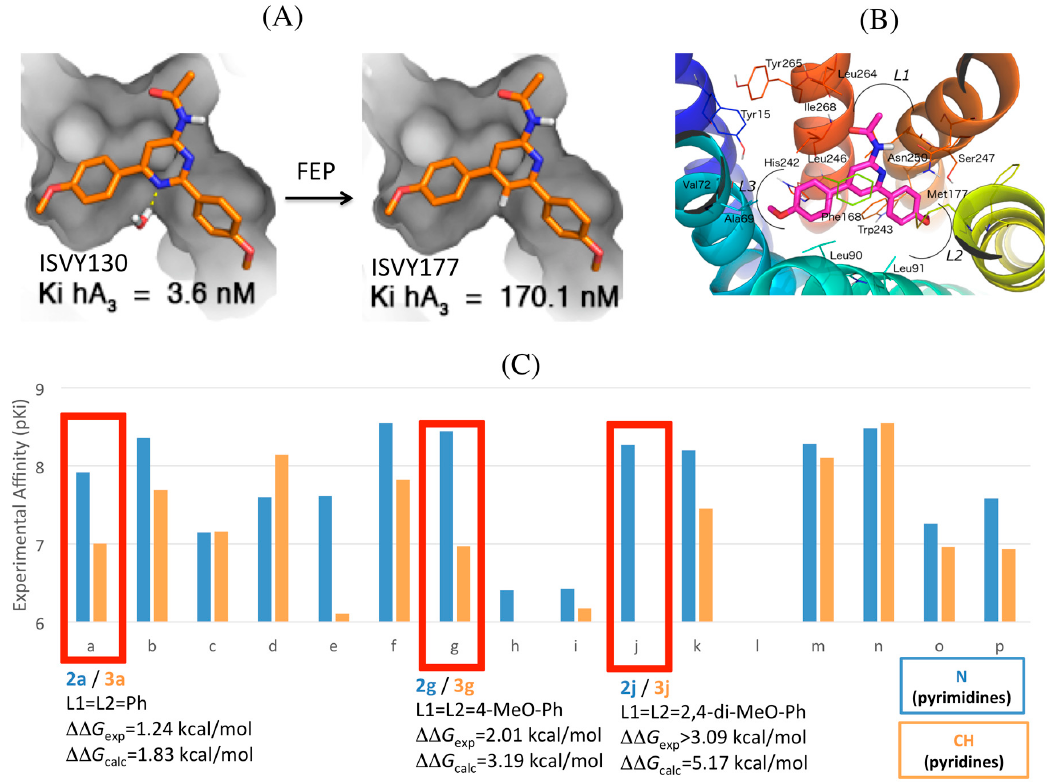
Figure 5. ( A ) Effect of the bioisosteric replacement of pyrimidine (left) by pyridine (right), showing the transformation of N into CH simulated by FEP. The increased affinity in the pyrimidine could be explained by the stabilization of a hydration site as part of a water-network in the binding cavity; ( B ) Binding orientation, common to the two series, is shown for pyridine ISVY177 ; ( C ) Experimental change in binding affinities for each pair of compounds between the two series, with correlation between the corresponding experimental and calculated free energy differences indicated for three selected pairs of compounds (red boxes).